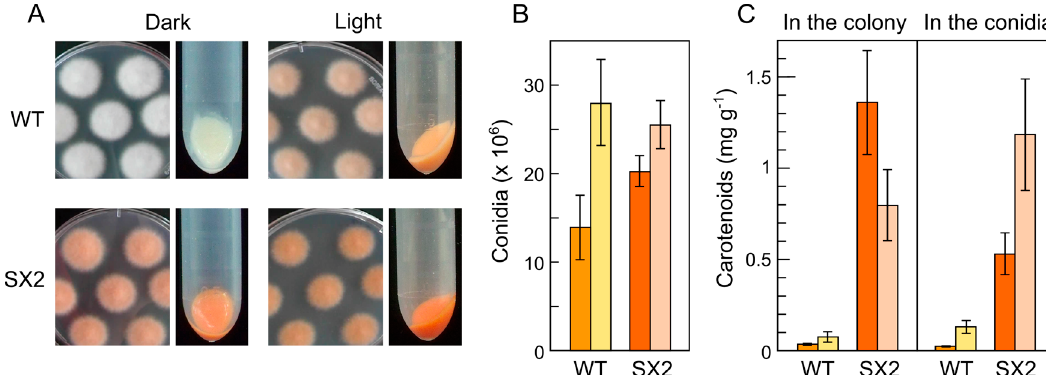
Figure 5. Conidiation and carotenoid biosynthesis in F. oxysporum . ( A ) Aspect of colonies of the wild type strain 4287 of F. oxysporum (f. sp. lycopersici ) and its carS mutant SX2 grown on DG minimal medium at 30 °C for 7 days in the dark or under 5 w m − 2 white light. Pictures on the right show the aspect of precipitated conidia obtained from the colonies as described [59]; ( B ) total amounts of conidia per Petri dish produced by the same strains under the indicated culture conditions; ( C ) total amounts of carotenoids accumulated in the mycelia and in the conidia mentioned above. The strains were grown in the dark (left darker bars) or under light (right paler bars). Data adapted from